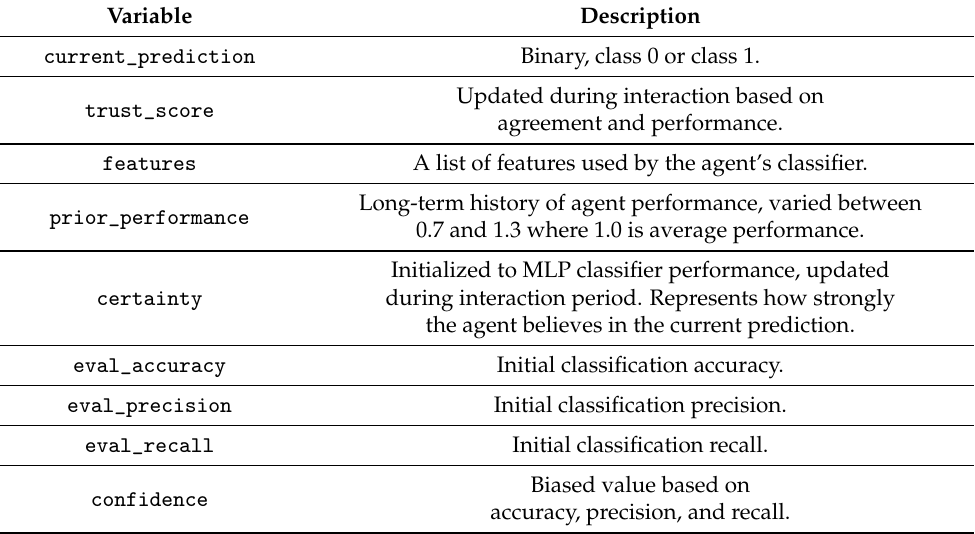
Table 1. Internal scoring